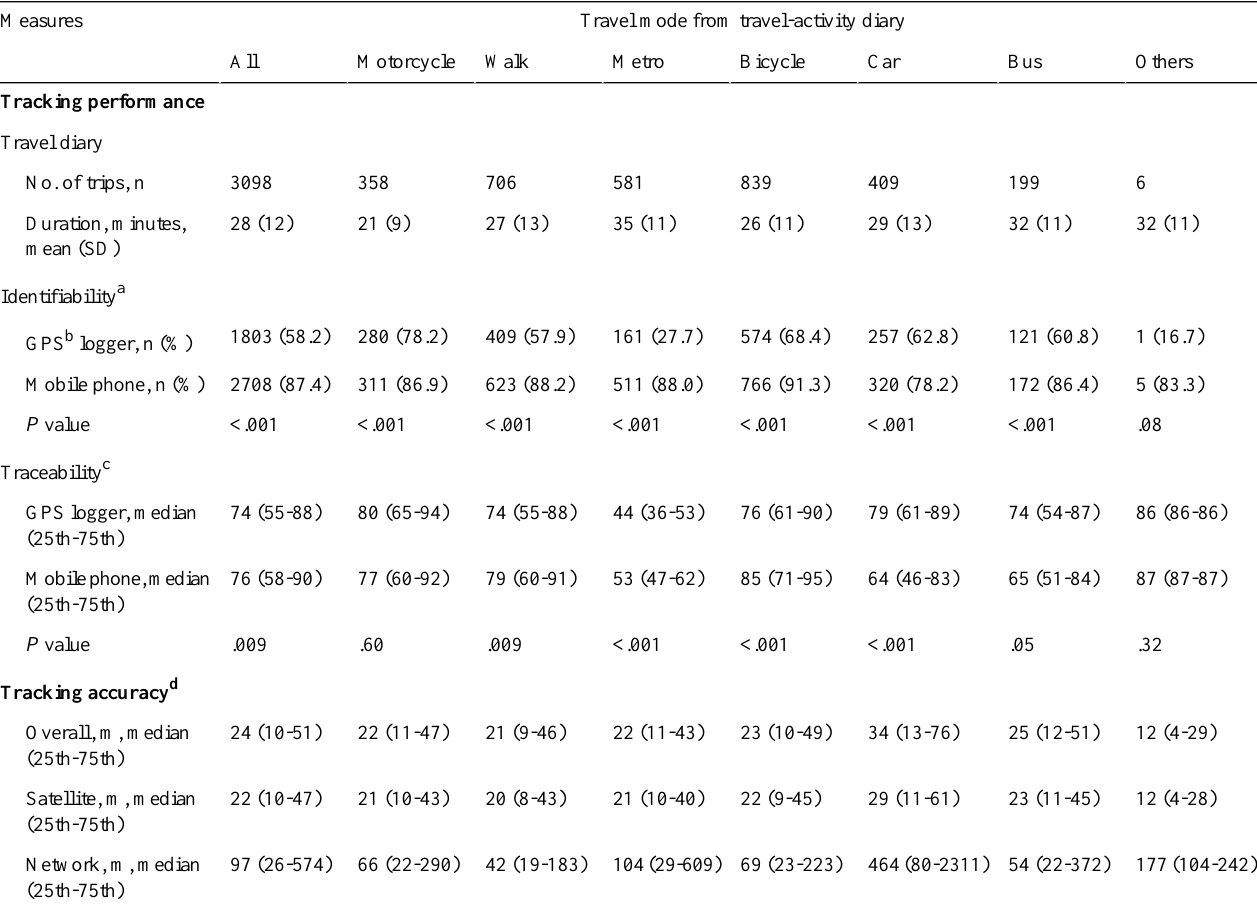
Table 2. Comparison of Global Positioning System and mobile phone tracking performance and description of mobile phone tracking accuracy. Travel mode from travel-activity